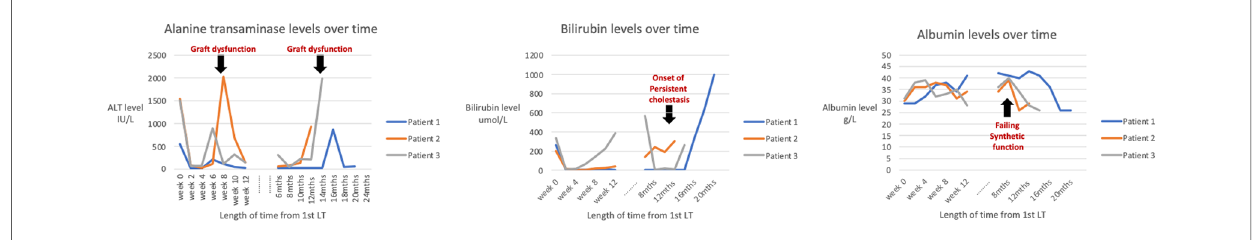
FIGURE 2 Line graphs of the alanine transferase (ALT), bilirubin and albumin levels at time points of “ graft dysfunction ” , onset of persistent cholestasis and falling albumin levels for each